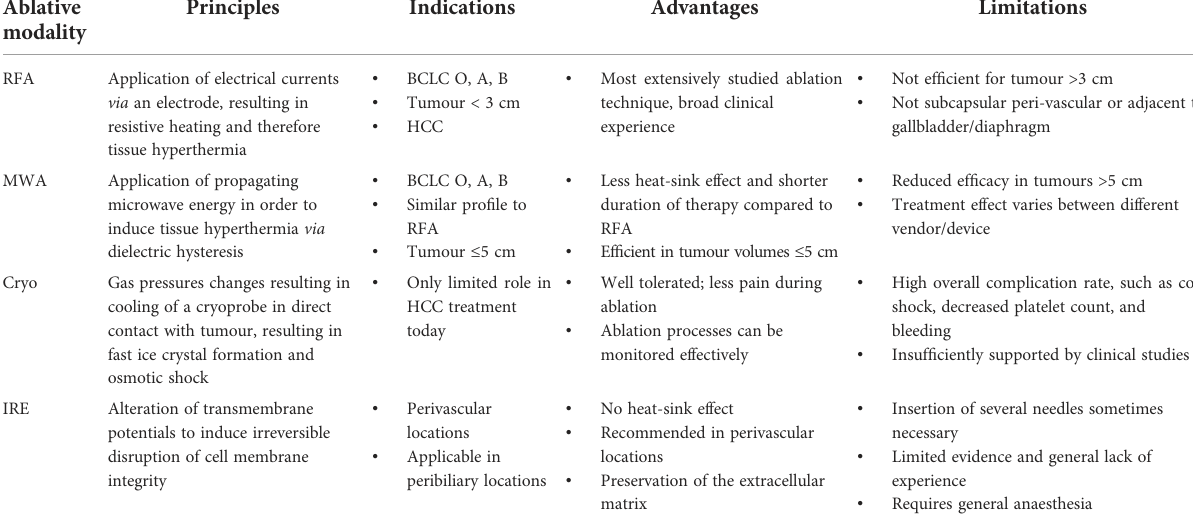
TABLE 1 Comparative scheme of the different types of ablation. Ablative Principles Indications Advantages modality